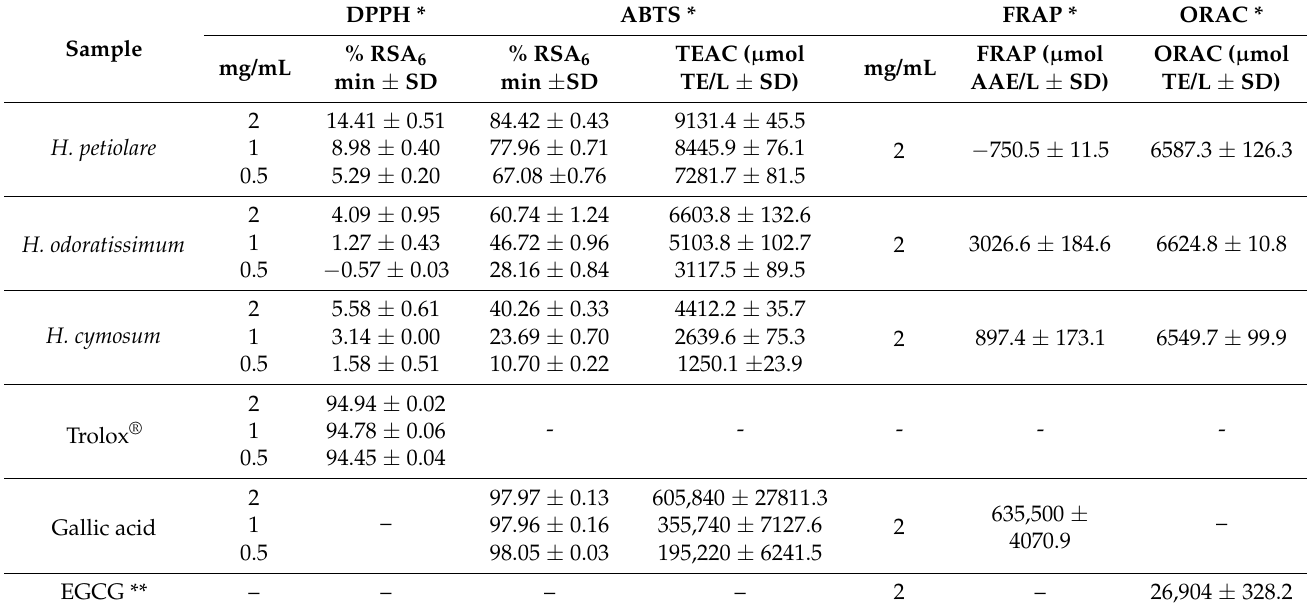
Table 6. Antioxidant capacities of Helichrysum EOs in the DPPH, ABTS, FRAP, and ORAC